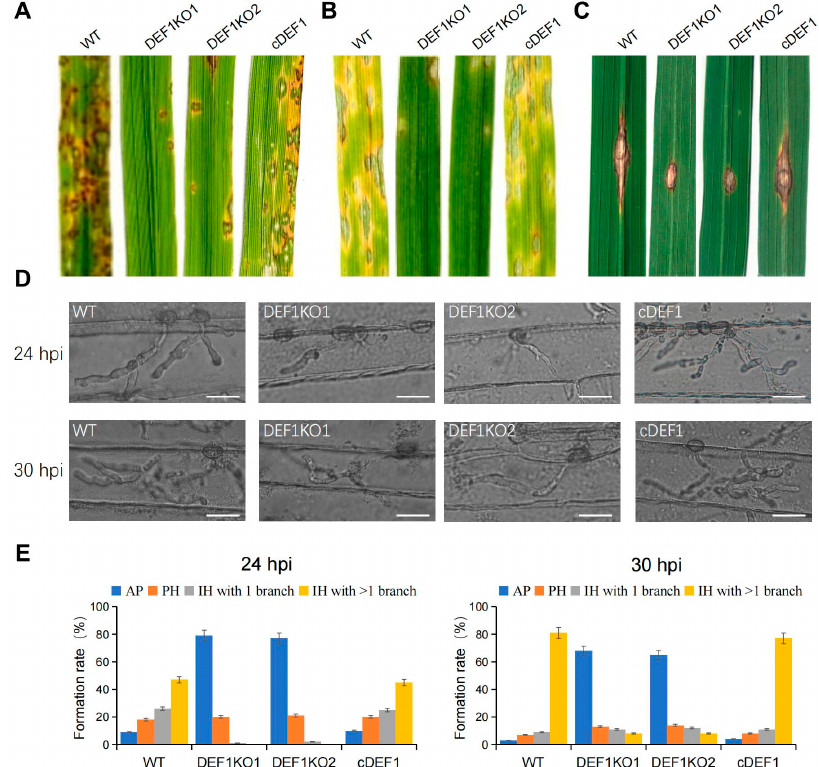
Figure 4. Def1 is required for full virulence of M. Oryzae . ( A , B ) Conidial suspension (5 × 10 4 /mL) of different strains were spray onto rice leaves ( A ) and barley leaves ( B ) and incubated for 5 days. ( C ) Mycelia blocks of different strains were inoculated onto the wounds of scratched rice leaves and incubated for 4 days. ( D ) Infection hyphae of different strains in Barley epidermal cells at 24 hpi and 30 hpi. Bar = 20 µ m. ( E ) Percentages of appressoria with infection hyphae at different stages. AP, appressorium with no infection hyphae; PH, primary infection hyphae; IH, secondary infection hyphae. WT, wild type; DEF1KO1 and DEF1KO2, two independent def1 knock out mutants; cDEF1, complementary strains.